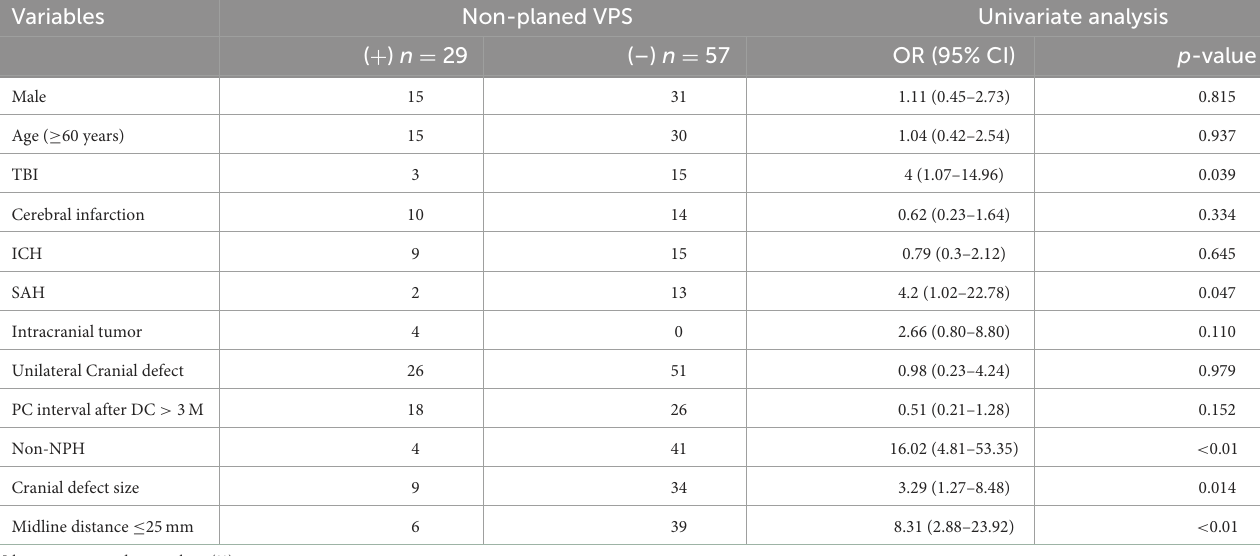
TABLE 4 Risk factor analysis for non-planed VPS after